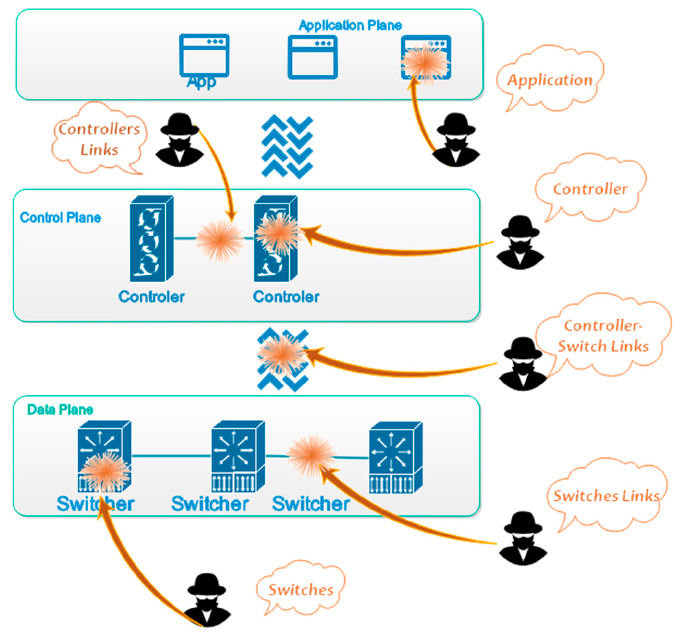
Figure 2. SDN Security Threats Target Points.